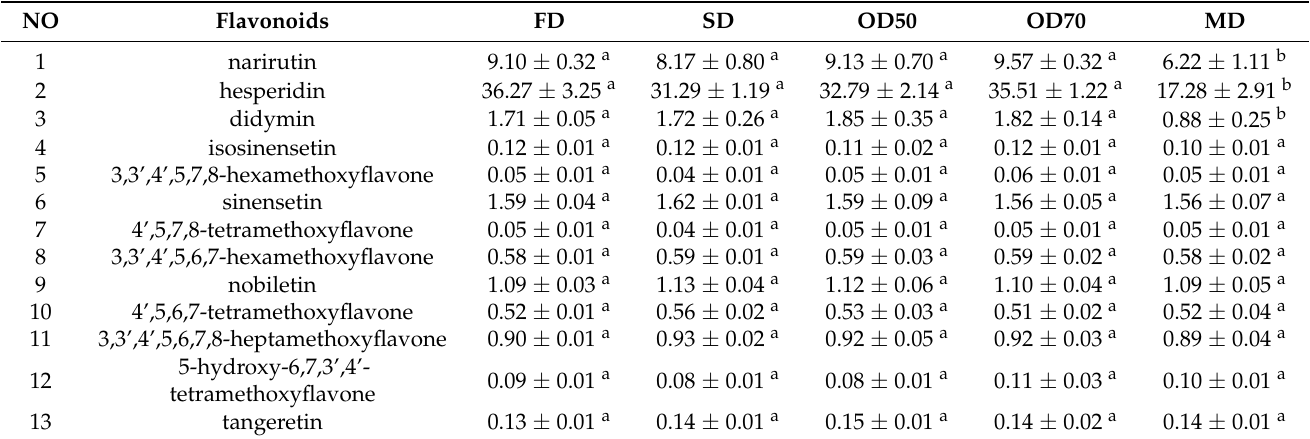
The data are reported as averages ± SD (three replicates). Different superscript lowercase letters within the same line indicate significant statistical difference ( p < 0.05). FD: Freeze drying. SD: Shade drying. OD50: Hot-air oven drying at 50 °C. OD70: Hot-air oven drying at 70 °C. MD: Microwave drying.